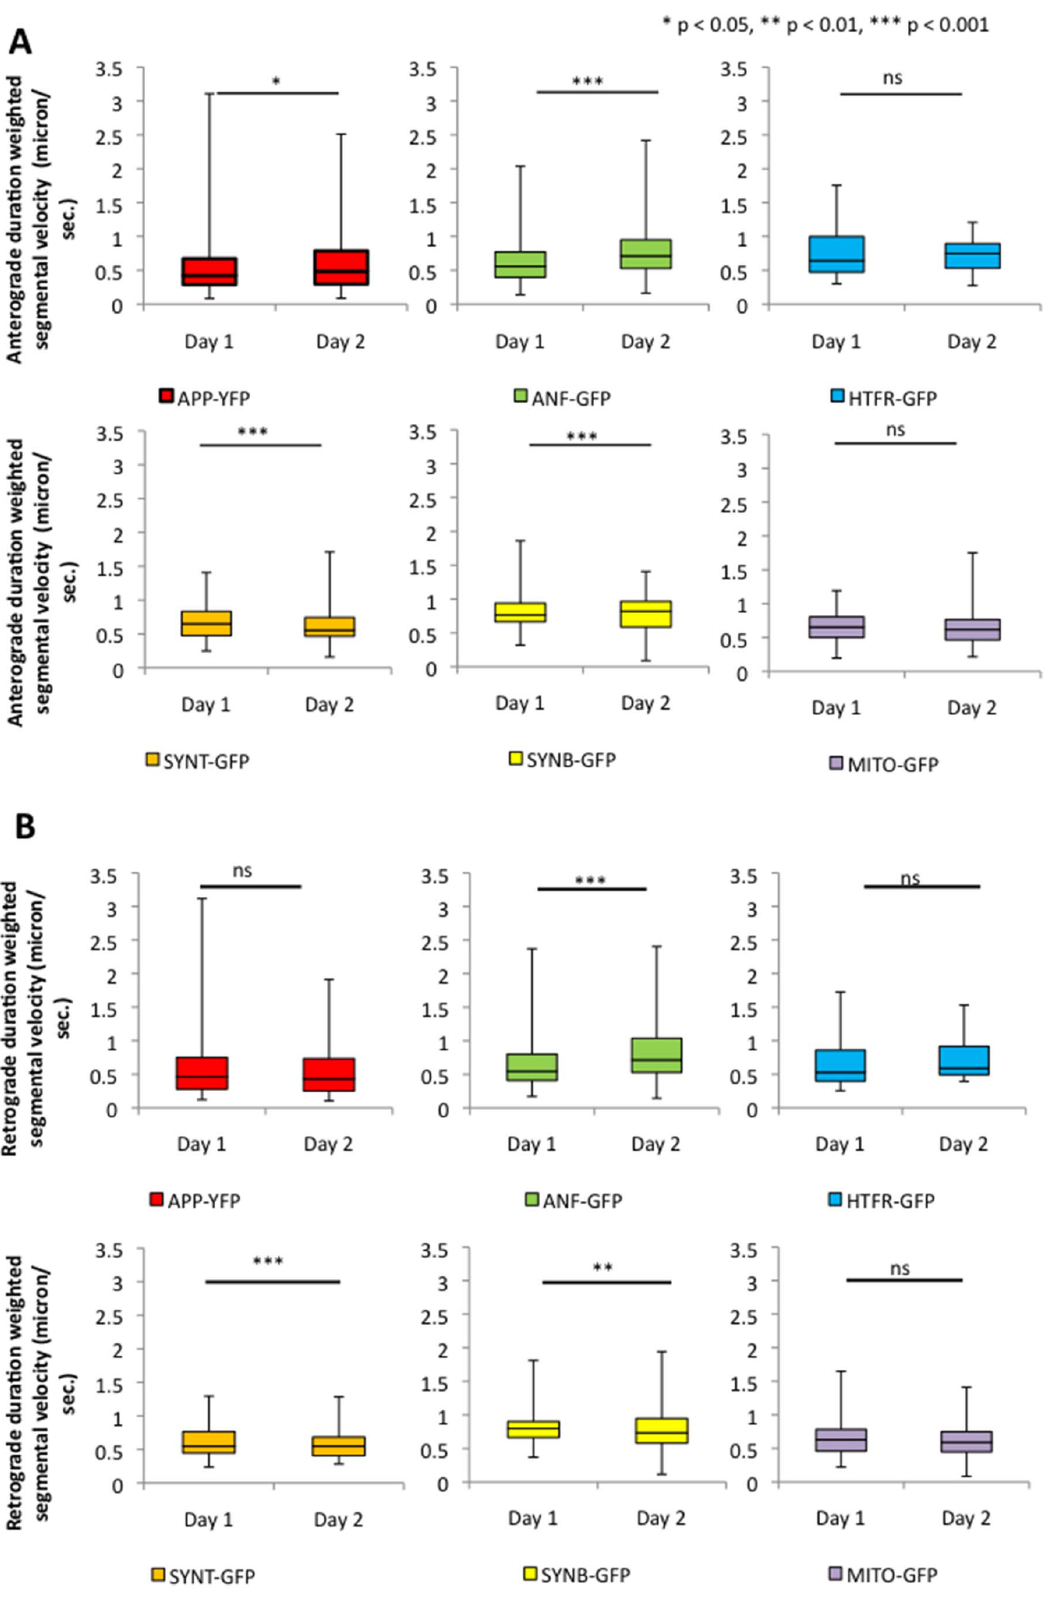
Figure 2. Anterograde and retrograde velocities of GFP/YFP tagged vesicles/cargo significantly change temporally. The average duration weighted segmental velocities of six vesicles/organelle revealed significant shifts in their movement dynamics at day 2 compared to day 1. Box-plots outline the distribution of vesicle velocities. Upper and lower box edges represent 75 th percentile and 25 th percentile respectively. Upper